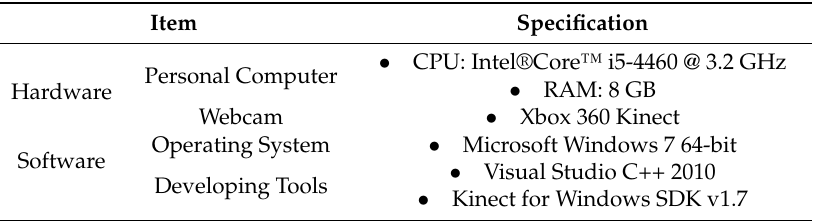
Table 1. Hardware and software used in our system.